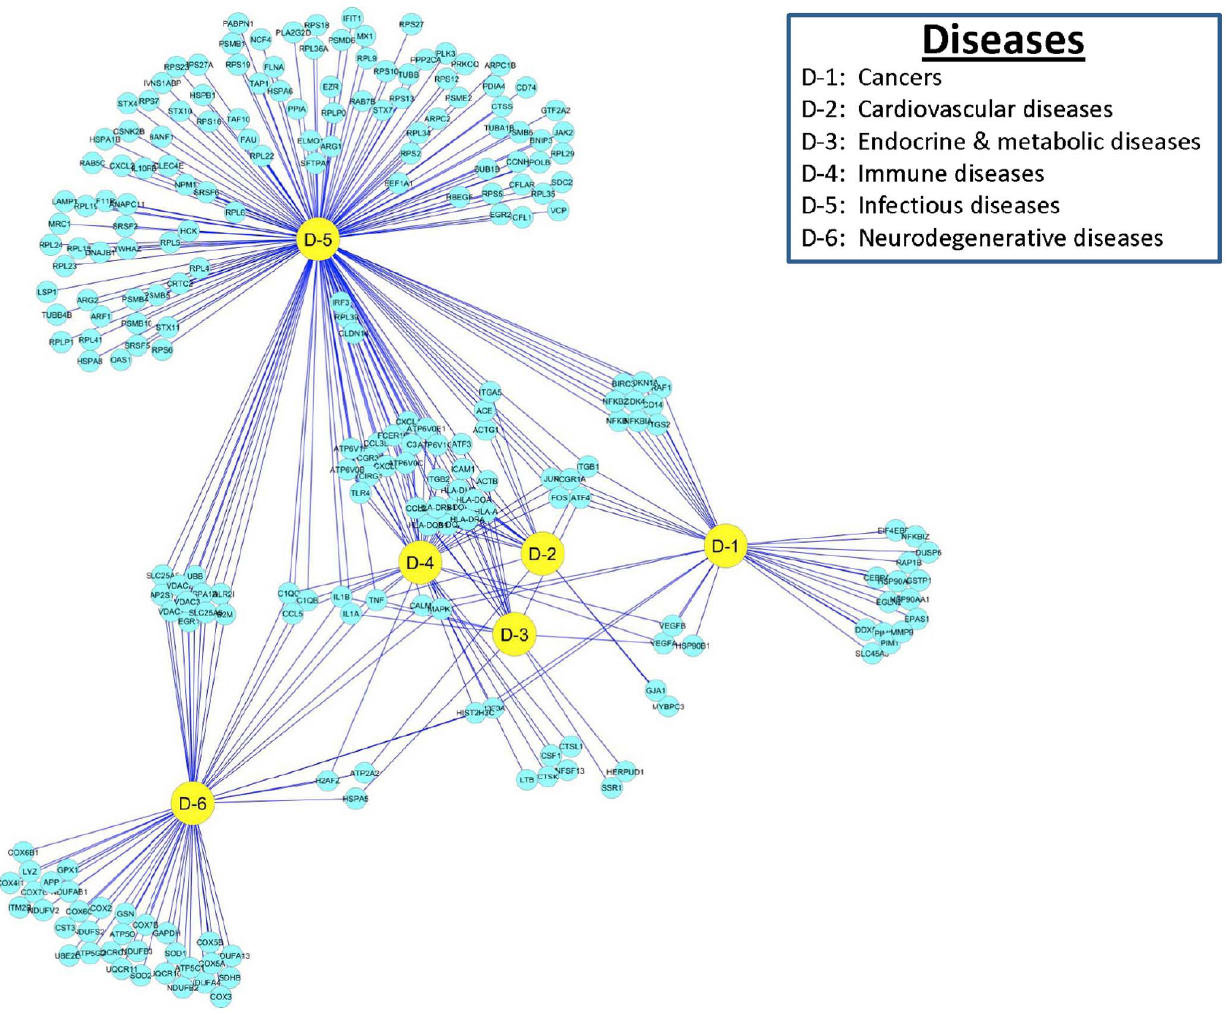
Figure 11. DE gene distributions and interactions among functional categories associated with Human Diseases in PAMs infected with PRRSV.